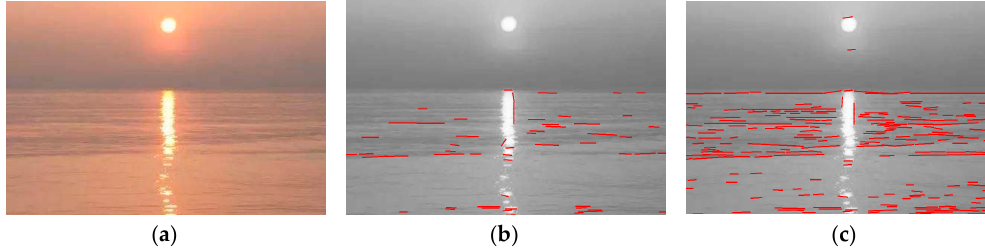
Figure 3. The direct application of the LSD algorithm with a false negative: ( a ) A given image with a horizon line that is very background-like due to vapor and illumination; ( b )The horizon line is ignored totally by the LSD algorithm, causing a false negative; ( c ) The results of this problem-specific design LSD for coarse detection.